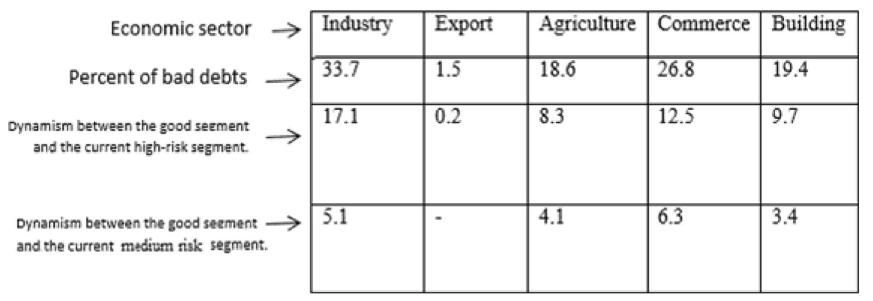
Table 6 Dynamism between segments. This table shows the dynamism of customers between segments of the bank ’ s static model and the proposed model in terms of economic sectors. For example, it shows that because of the sanctions 17.1% and 5.1% of the customers have moved from the good segment to the bad (i.e. high-risk) segment,